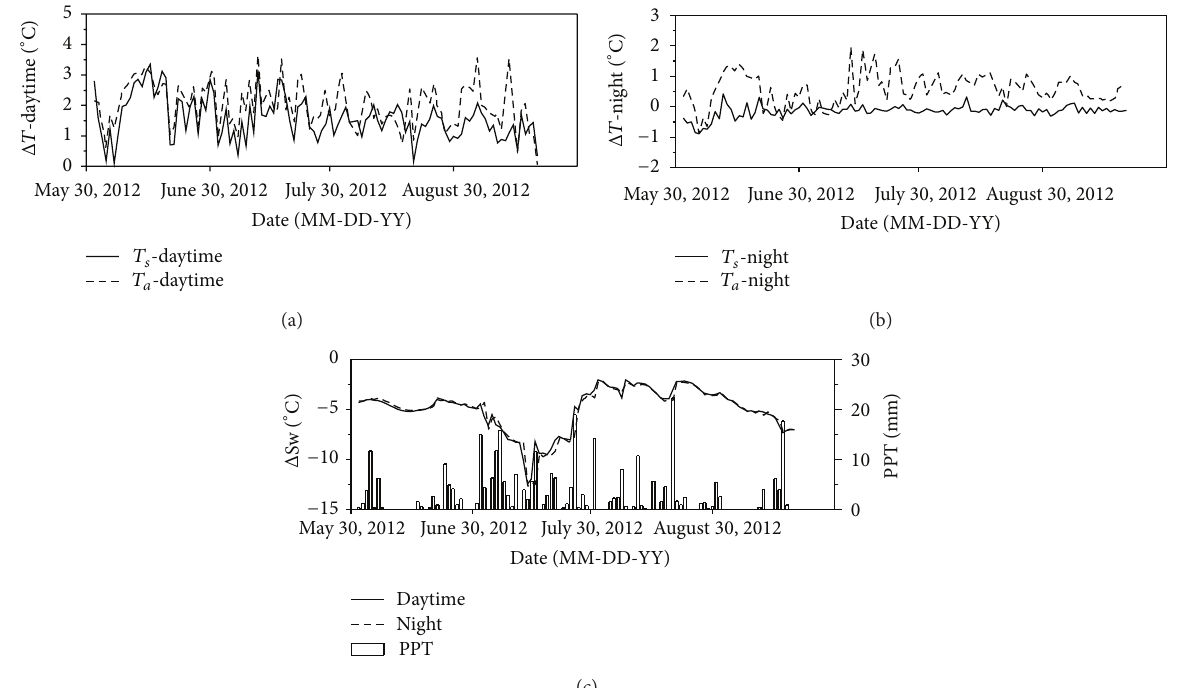
Figure 1: Effects of simulated warming on meteorological factors over growing season in 2012. Daytime and nighttime air temperature ( 𝑇 𝑎 ), soil temperature ( 𝑇 𝑠 ), and soil water content (Sw) at the depth of 0 ∼ 5cm represent the difference between the values inside OTCs and the ambientconditionsindaytime(07:30 ∼ 20:30)andnighttime(00:00 ∼ 7:30and20:30 ∼ 24:00),respectively.PPTrepresentsthedailyprecipitation from June 1 to September 30, 2012.